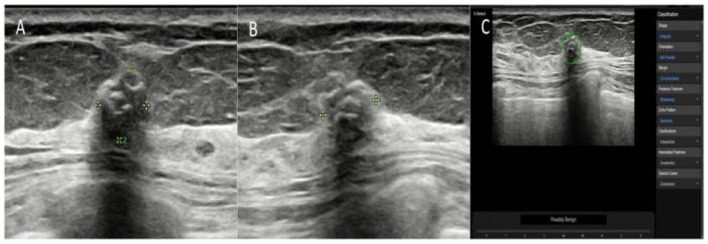
The breast mass of an asymptomatic 57-year-old woman. (A,B) The longitudinal section and cross-section of the lesion showed a 6-mm mass with calcifications and posterior shadowing. The orientation is not parallel. The experienced radiologists diagnosed the lesion as BI-RADS 4a. (C) A ROI was automatically drawn along the margin of the mass (green line). The raw imaging data were automatically analyzed, and the final diagnosis of the deep learning-based CAD system was a possibly benign tumor. The mass was pathologically proven to be a fibroadenoma.